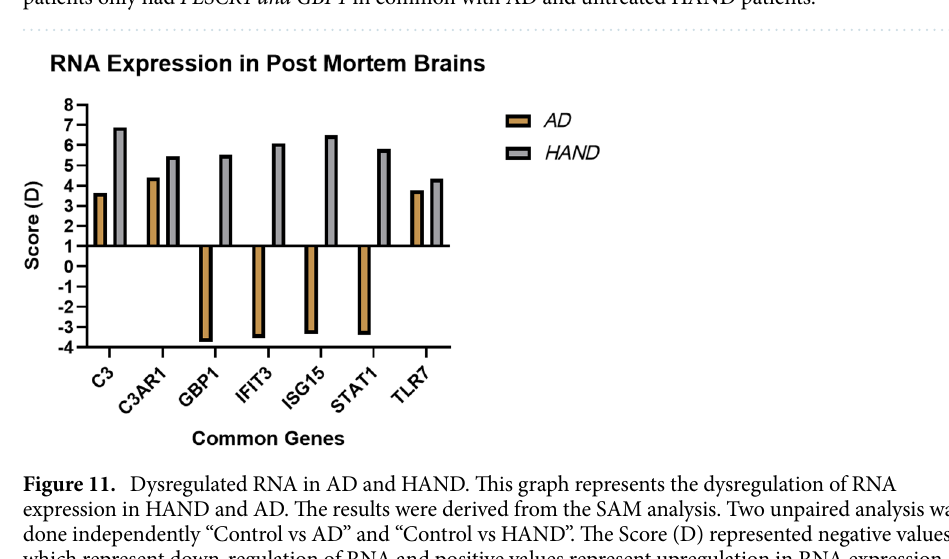
Figure 10. SAM results in comparison of untreated HAND and AD patients (basal ganglia). This Venn diagram represents the SAM results that were considered significant (q-value = < .05). Both SAM analyses were done independently and then compared. The basal ganglia regions of AD patients had 40 downregulated genes (red). While the HIV-1 patients only had 14 genes up-regulated (blue) based on mRNA expression. The white matter region of untreated HAND patients had a total of 397 upregulated genes (blue) and 52 downregulated genes (red). In comparison, untreated HAND and AD shared 7 genes in common seen in purple. While HIV-1 patients only had PLSCR1 and GBP1 in common with AD and untreated HAND patients.